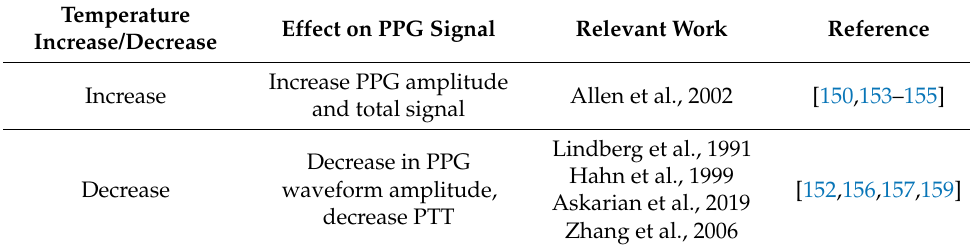
Table 5. Factors that affect local body temperature that affect